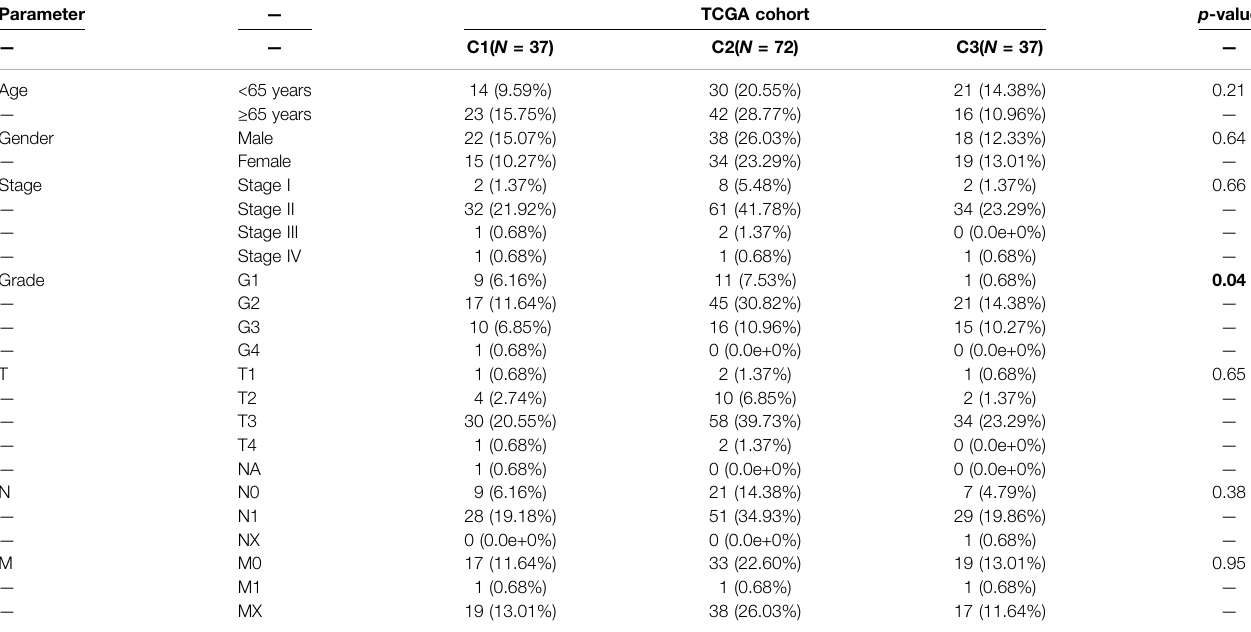
TABLE 1 | Correlation of C1, C2, and C3 subtypes of clinicopathological features in patients with PDAC from TCGA cohort. Parameter